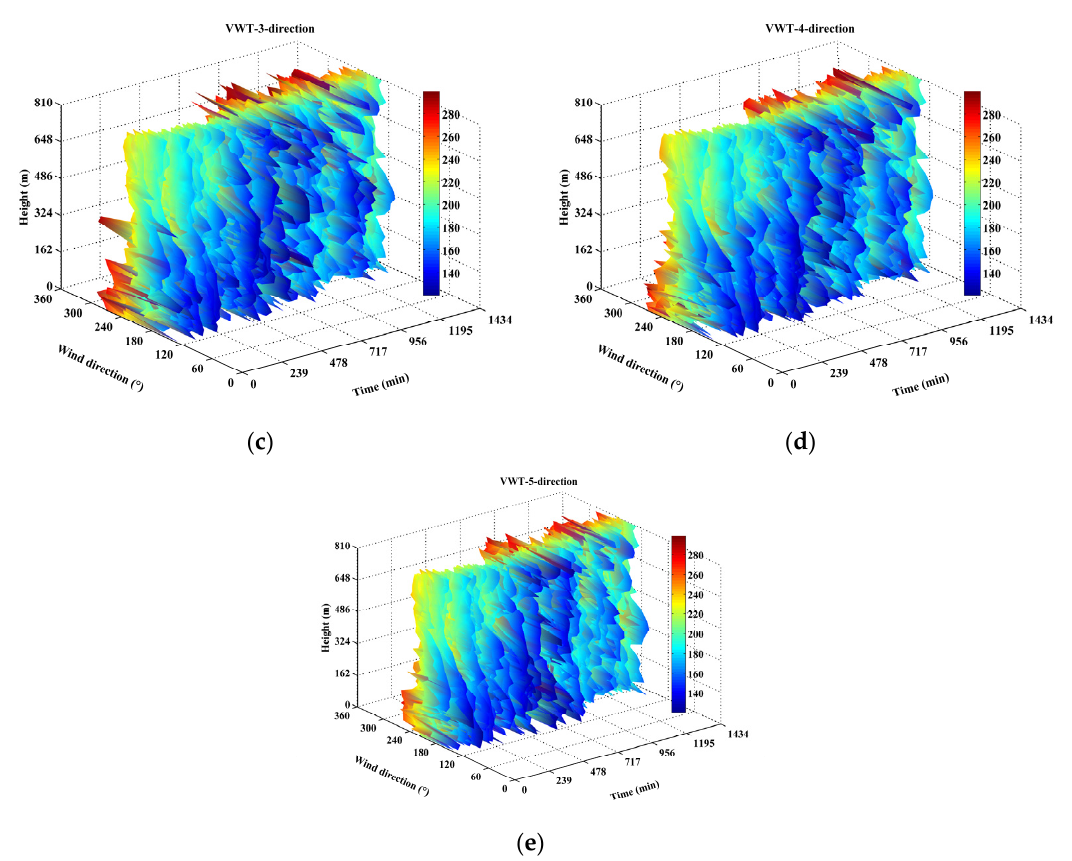
Figure 13. Spatio-temporal distribution of wind direction, ( a ) VWT-1; ( b ) VWT-2; ( c ) VWT-3; ( d ) VWT-4; ( e ) VWT-5.